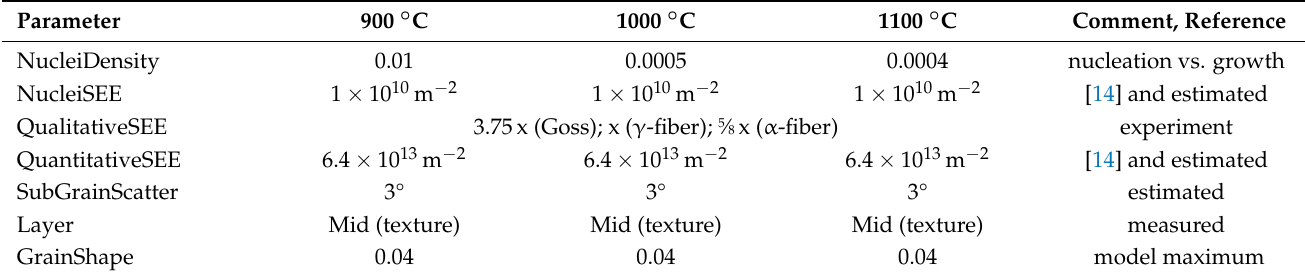
Table 4. Input parameters and their origin for the microstructure generator for the annealing temperatures 900°C, 1000°C and 1100°C.